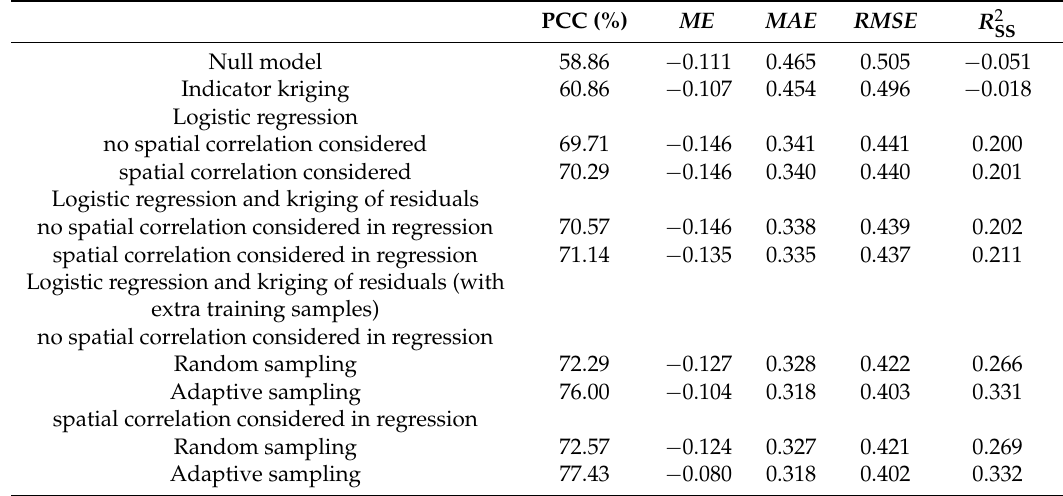
Table 6. Comparison of methods for predicting classification